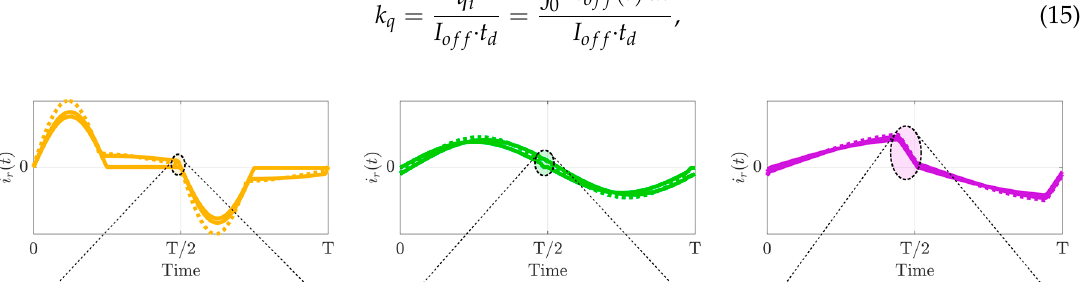
Figure 15. Time-based model simulations: inductive charge ( 𝑞 (cid:3036) ) and transistor output capacitor charge ( 𝑞 (cid:3042)(cid:3046)(cid:3046)_(cid:3021)(cid:3042)(cid:3047)(cid:3028)(cid:3039) ), where iZVS stands for incomplete ZVS. ( a ) for 𝑚 = 10 ; ( b ) for 𝑚 = 215 .